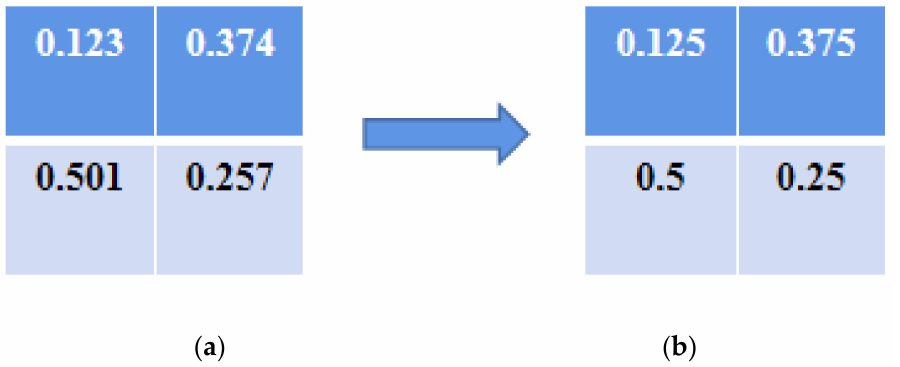
Figure 6. An illustration of w j and Cw j . ( a ) w j . ( b ) Cw j